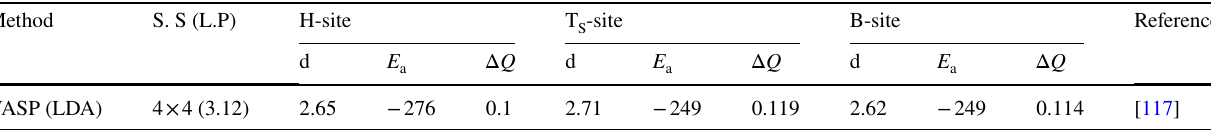
Table 1 Method, supercell size (S.S), lattice parameter (L.P) and favorable adsorption sites on MoS 2 calculated by Yue et al. using DFT [117]